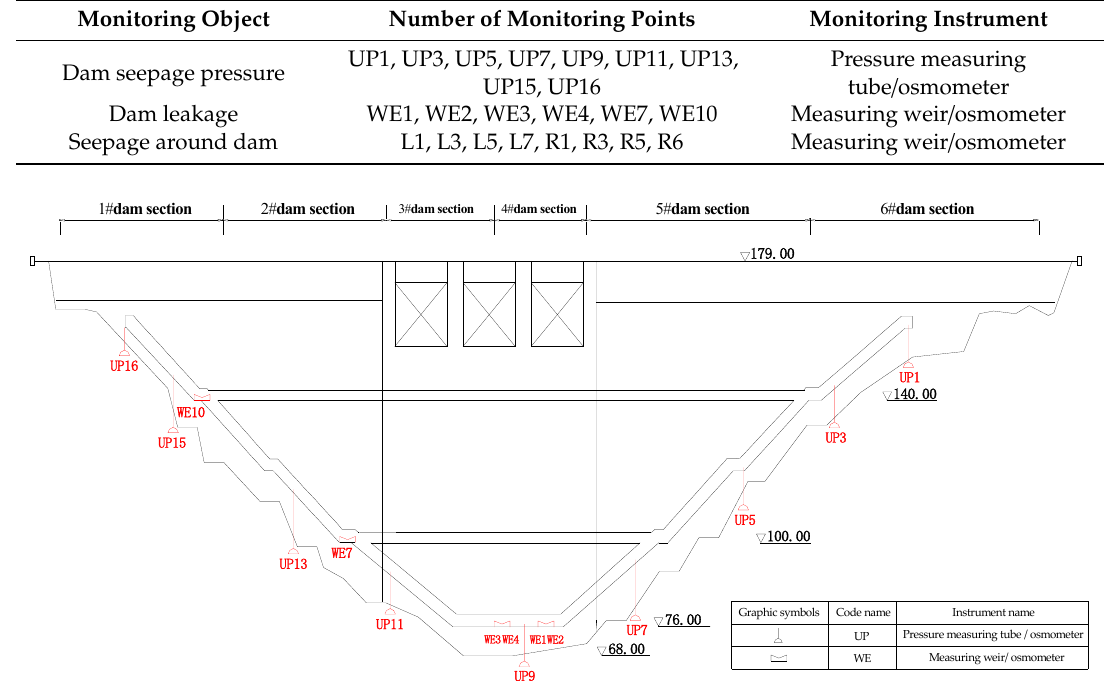
Table 1. The information of monitoring points.